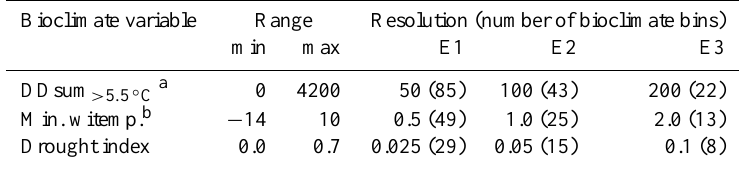
Table 2. Three sets of bioclimate bins (E1, E2 and E3) were used to pre-structure the simulation areas. The bioclimate bins resulted from discretising the bioclimate variables with different granularity (E1: fine, E2: moderate, E3: coarse). Minimum and maximum values of the bioclimate variables cover the bioclimate ranges of both application scenarios. Bioclimate variable